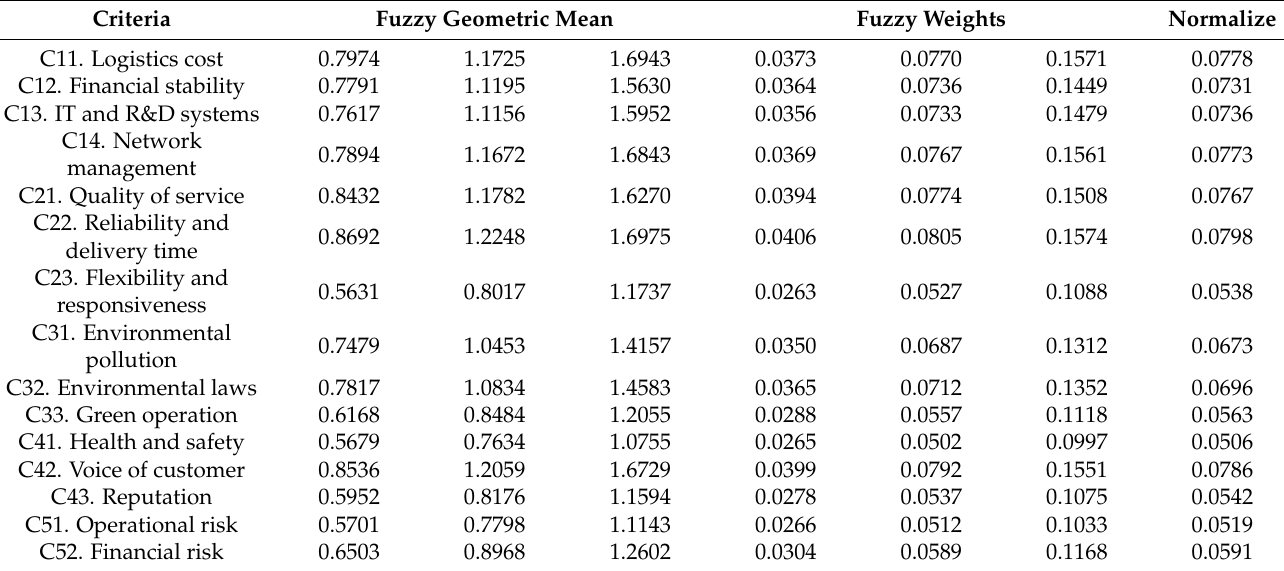
Table 9. The relative significant fuzzy weights of each criterion of FAHP model.